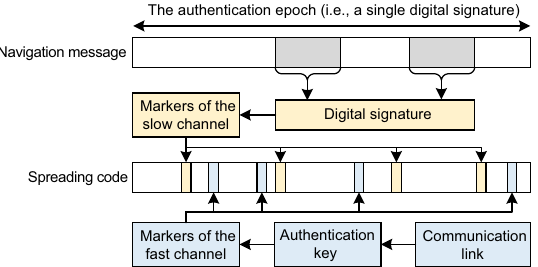
Fig. 3 The NMA of the Chimera scheme is constructed through the digital signature of the navigation message. The SCA is achieved by inserting markers into the civilian spreading code. The yellow blocks in the figure above indicate the authentication of the slow channel, while the blue blocks indicate the fast